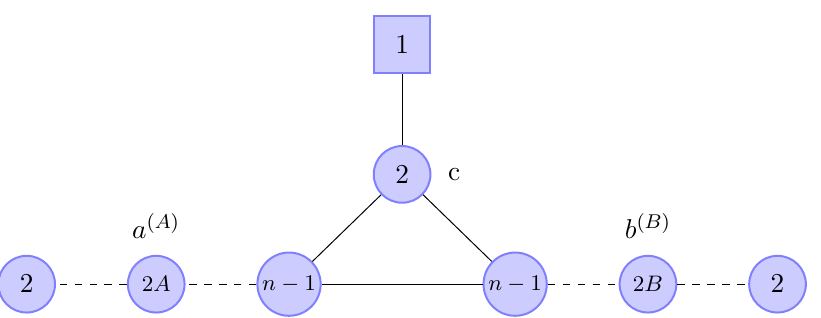
Figure 20 . We reproduce the quiver from (cid:12)gure 12 but rotated and with labels a ( A ) 2 Z 2 A ; b ( B ) 2 Z 2 B ; c 2 Z 2 denoting magnetic charges through the corresponding gauge nodes (the nodes to the left of the central U(2) node have (cid:13)uxes labeled by \ a ", while those to the right have (cid:13)uxes labeled by \ b